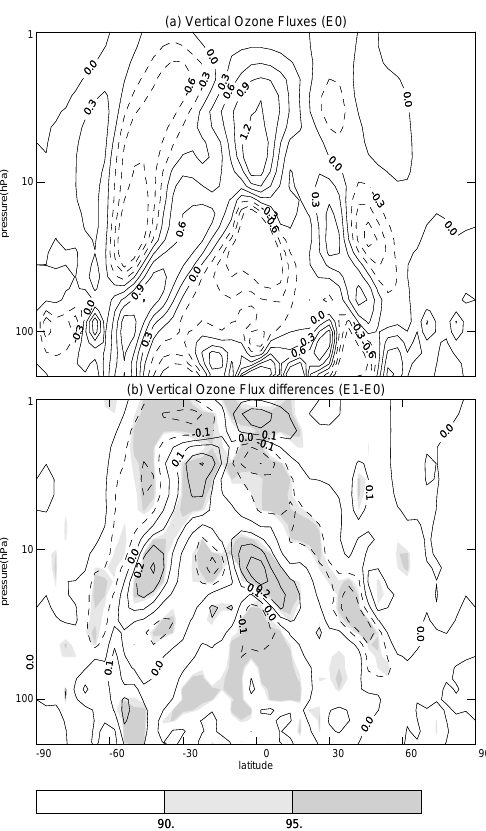
Figure 9. Vertical ozone fluxes associated with the BD circulation ( w ∗ ) calculated from (a) reference experiment (E0) and (b) the dif- ferences between E1 and E0 (for more details of the definition of ozone flux see text) over the last 10 years. The contour intervals are 0 . 3 × 10 3 kgs − 1 and 0 . 1 × 10 3 kgs − 1 in (a) and (b) , respectively. Grey colours (b) represent the statistical significance levels for the mean state differences between different experiments by Student’s t